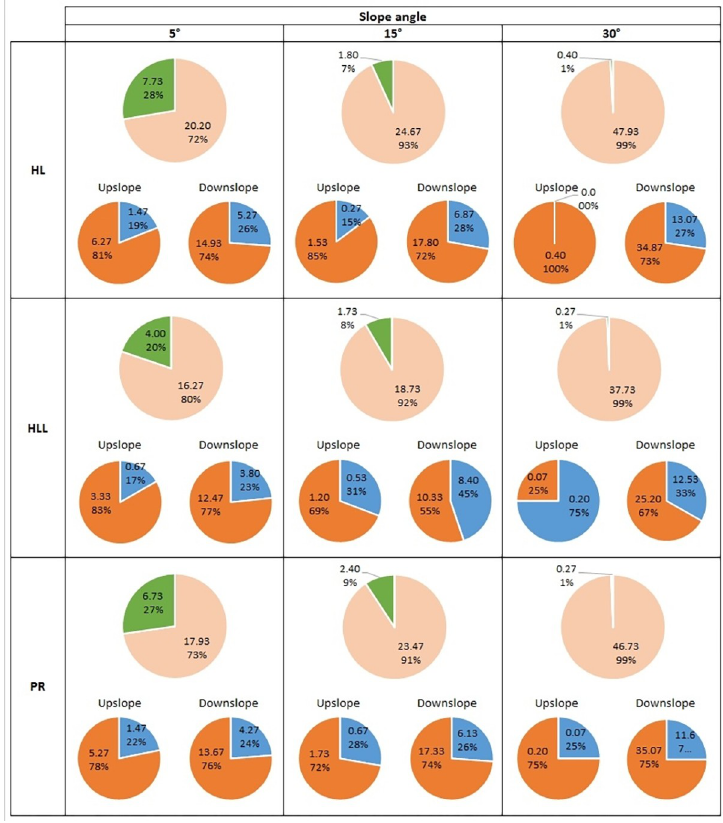
Fig 3. Proportions of ejected material on dry soil samples with different inclines. The upper graph shows the total ejected material in the upslope (green colour) and downslope (slight beige colour) directions. The lower graphs present the proportions of soil (brown) and water (blue) in the ejected material for both directions. Symbols for soils: